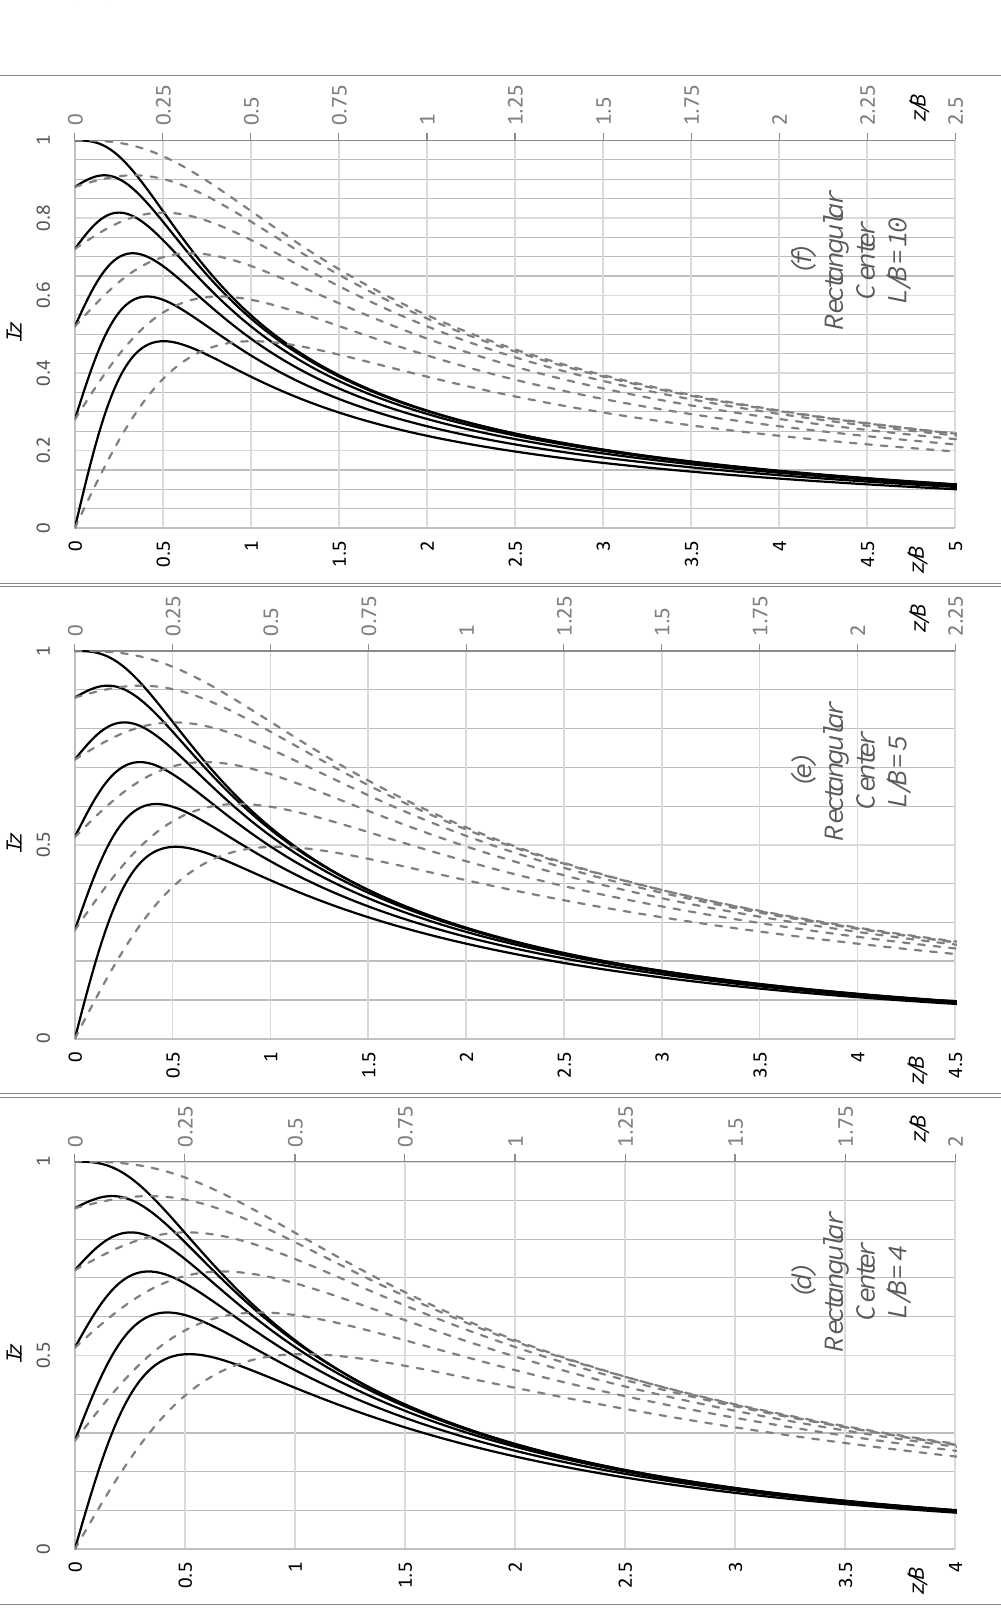
Figure 3. I z versus normalized depth charts referring to the center of flexible rectangular footings for various ν values; ν ranges from 0.5 to 0 (left to right) with 0.1 interval.